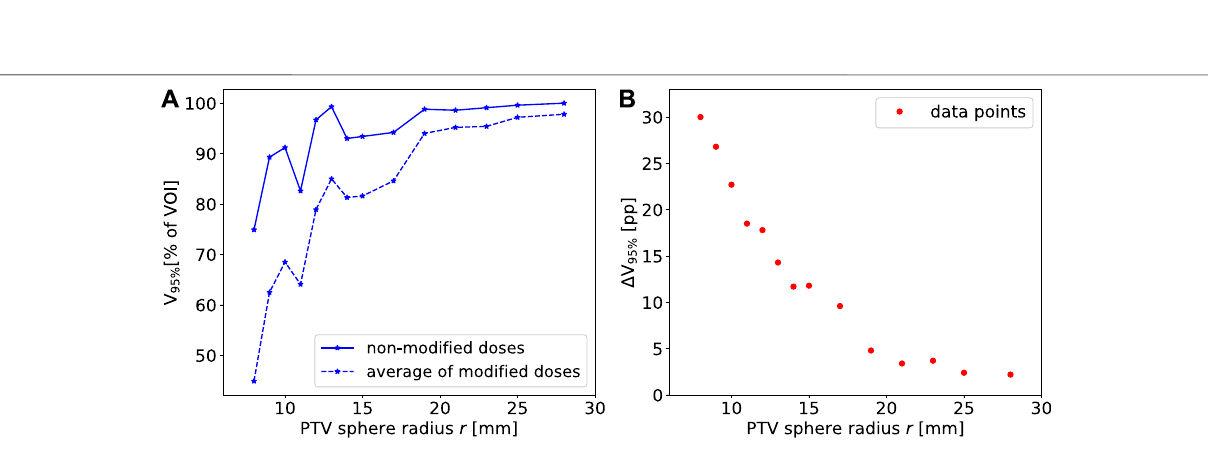
Frontiers in Physics |